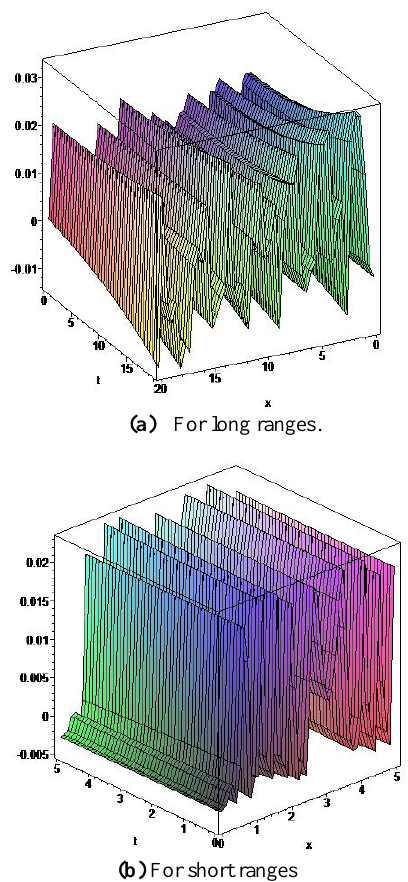
Figure 2. The solution for 𝑅 = 0.1,𝐿 = 63,𝛿 = 0.1, 𝑐 0